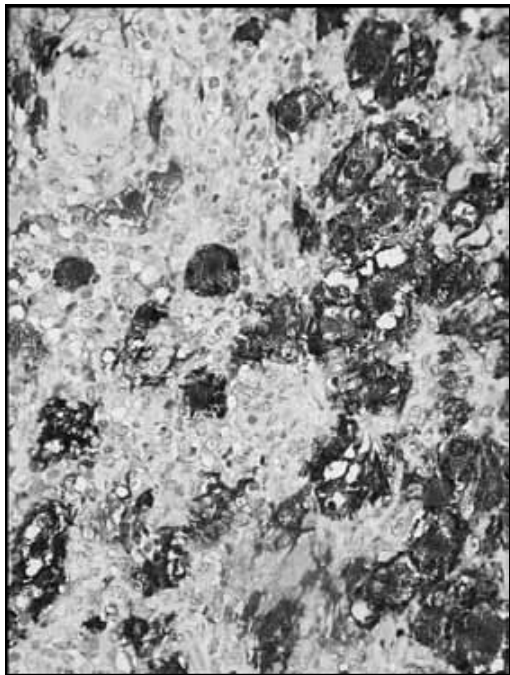
Figura 6 – Marcação imuno-histoquímica para proteína S100